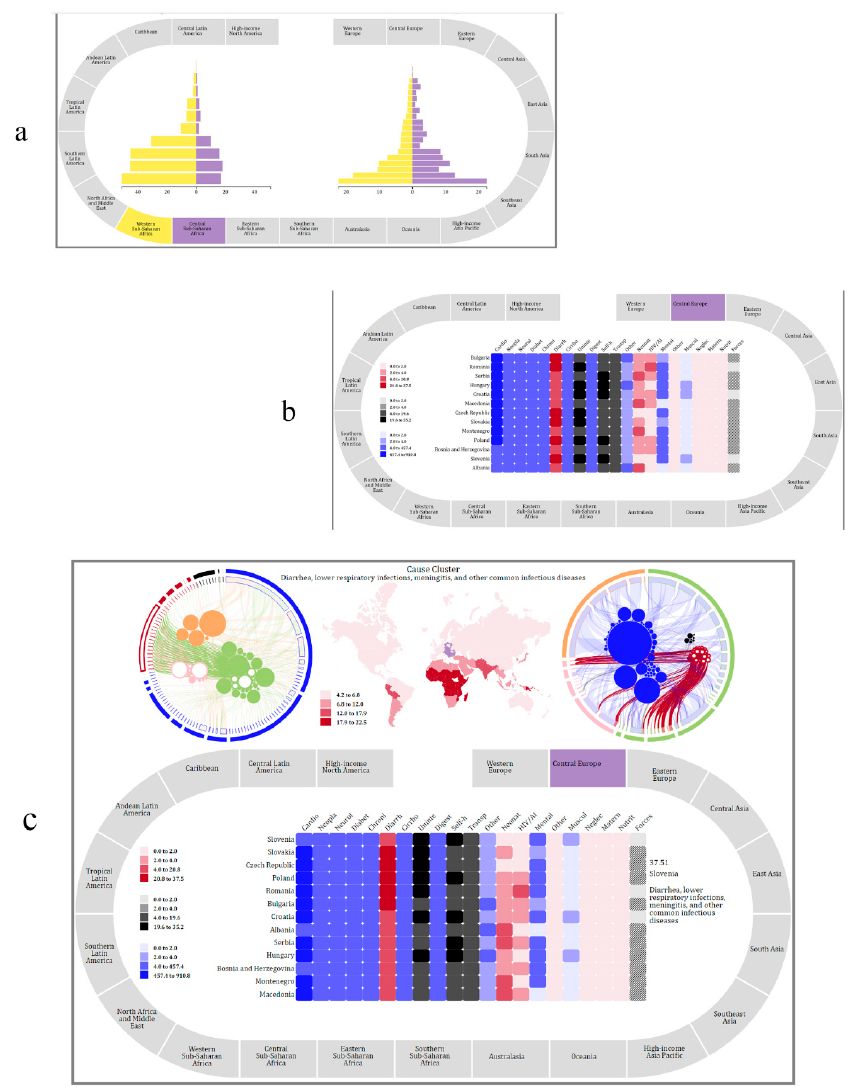
Figure 10. ( a ) Bottom portion of the geography visualization, comparing risk- and cause-clusters for two regions in African; ( b ) bottom portion of the visualization, with central Europe selected and the heatmap arranged in a configuration to support understanding mortality rates for Bulgaria; ( c ) geography visualization in which the bottom portion supports comparing countries in eastern Europe affected by diarrheal diseases and the top portion shows the impact of the cluster at a regional level.